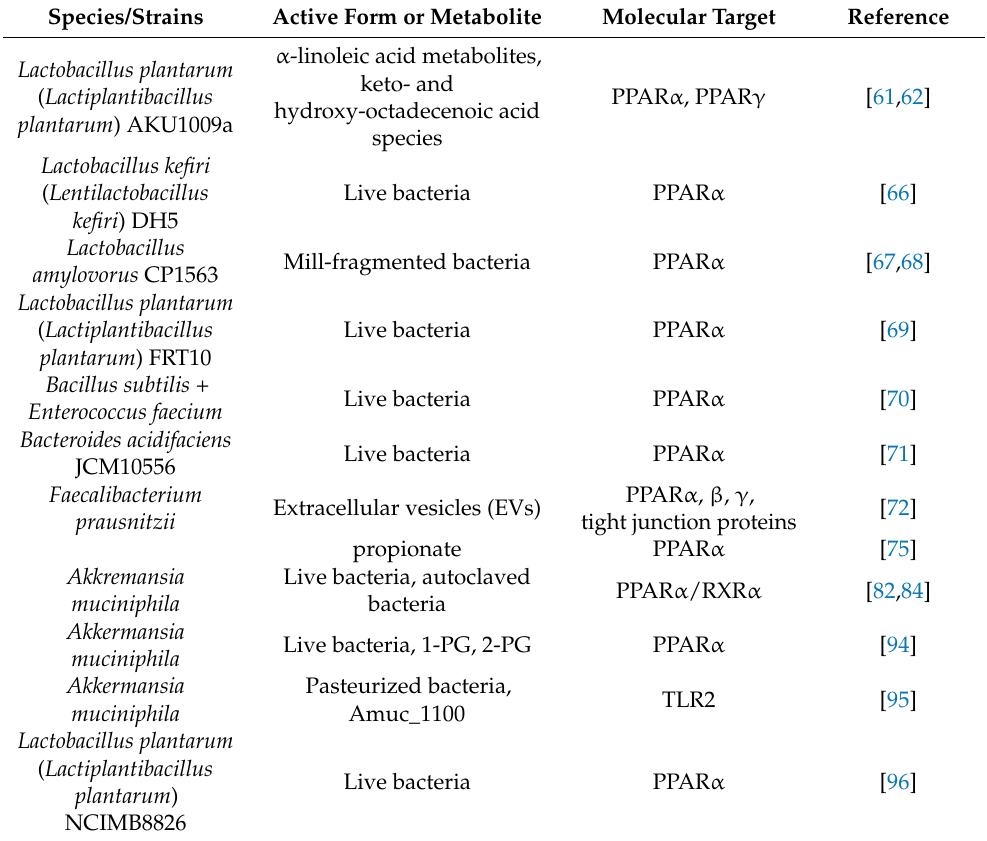
Table 2. The experimental evidence that microbiota modulate PPAR α signaling. The bacterial species names are taken from the original references, but in certain cases, the new species names according to the updated taxonomic nomenclature of the genus Lactobacillus [64] are given in